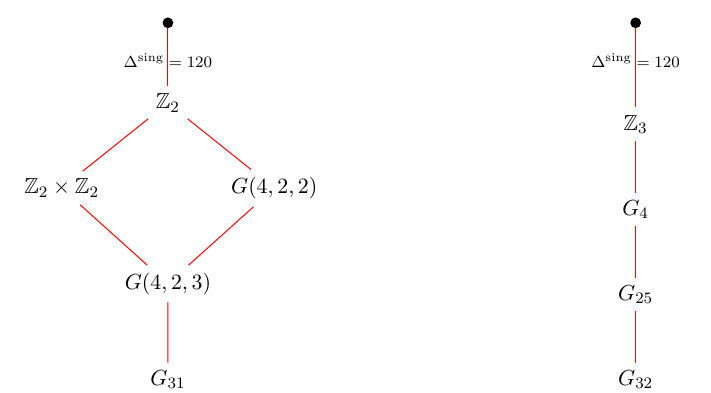
Figure 5 . Hasse diagrams for the moduli space of the N = 3 theories obtained from the type- e 8 (2,0)